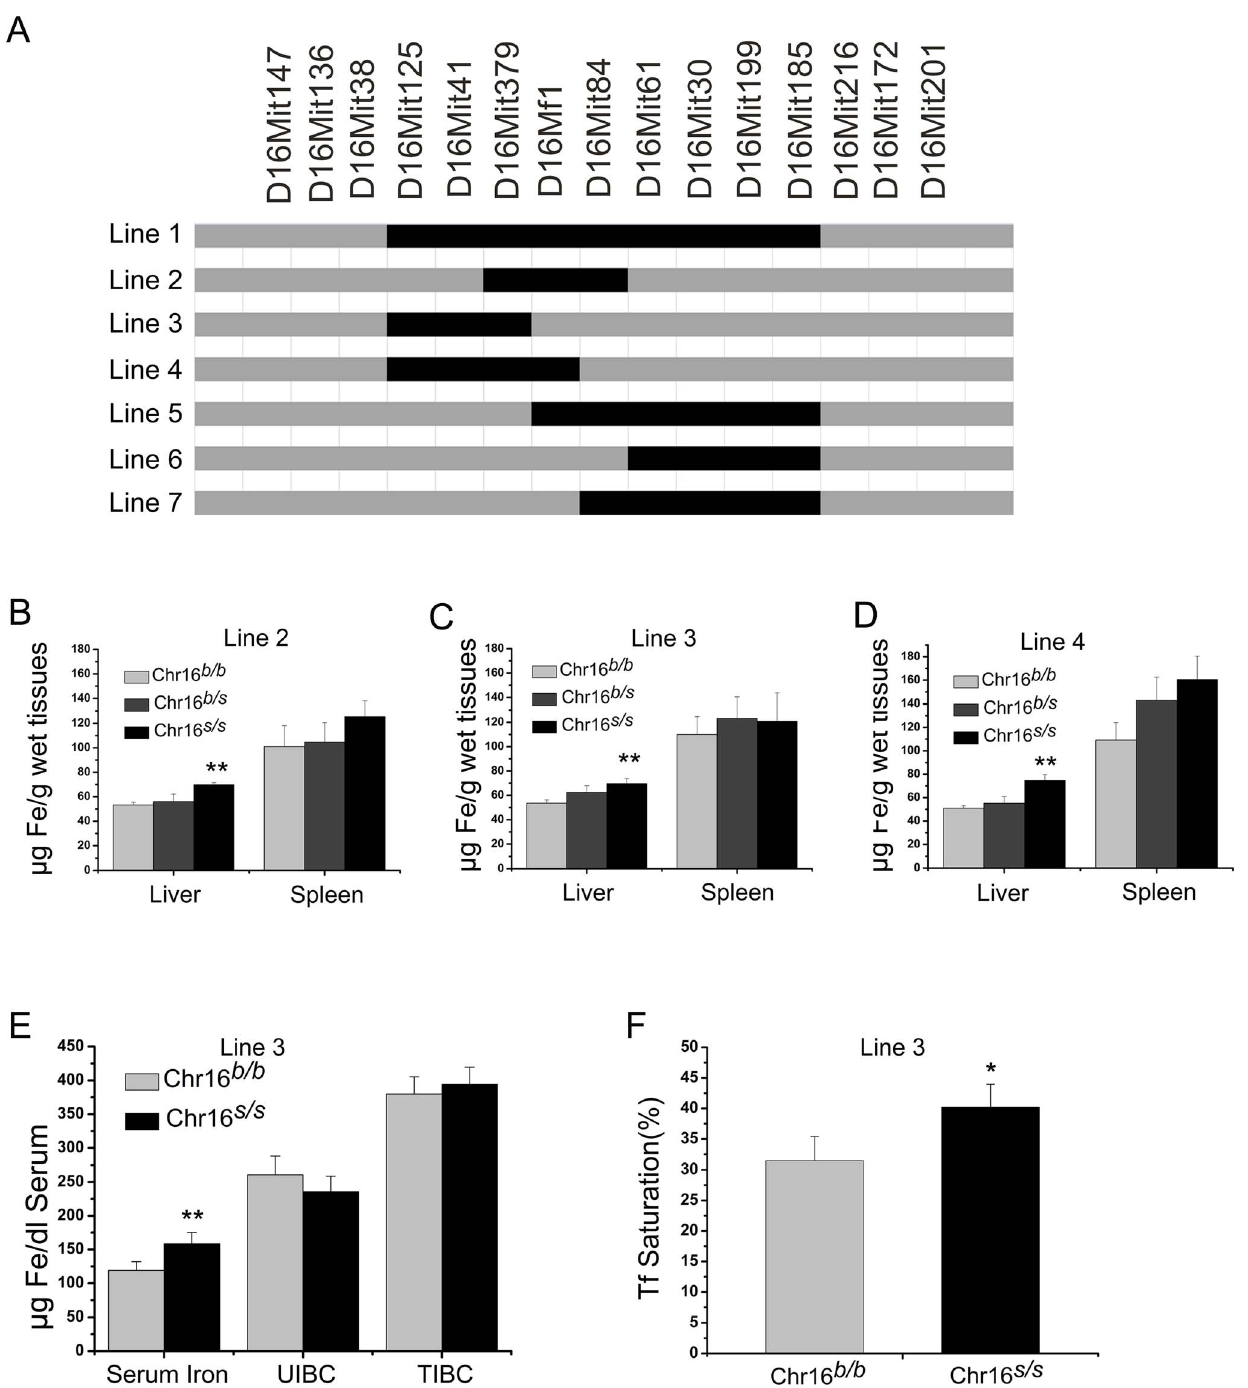
Figure 2. Haplotypes and iron phenotype analysis of subcongenic lines of Chr16. (A) Map of subcongenic lines derived from the original line. (B–D) Measurement of liver and spleen non-heme iron of congenic Line 2, Line 3, and Line 4 (n . 5 per group). (E) Serum iron, unsaturated iron binding capacity (UIBC), and total iron binding capacity (TIBC), and (F) Serum transferrin saturation (Tf %) measurement of congenic Line 3. Data represent mean 6 SEM. * P , 0.05, ** P , 0.01.